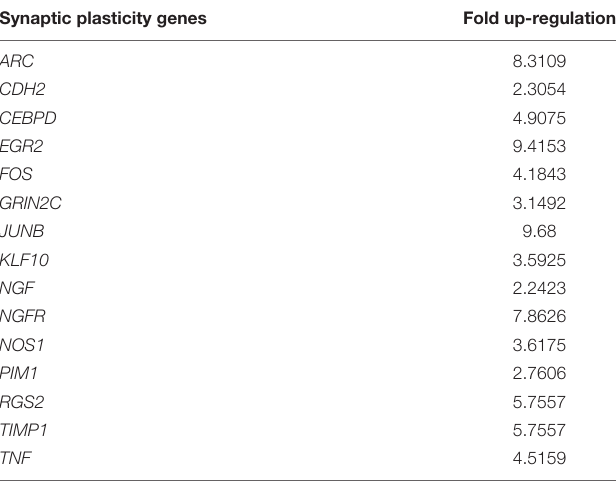
TABLE 3 | Human synaptic plasticity genes expression in mithramycin A-treated SH-APP cells. Synaptic plasticity